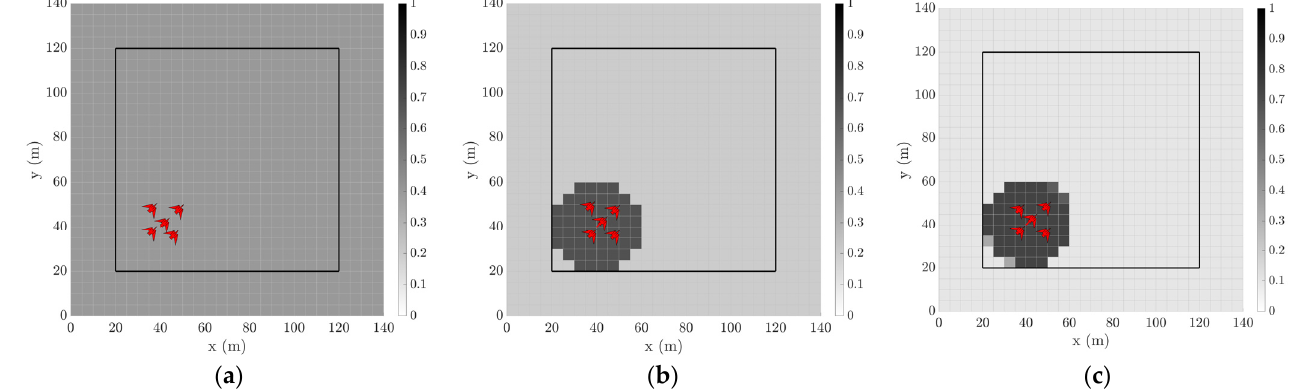
Figure 1. Target probability map over incremental time steps (darker cells represent higher probability of target occupancy based off sensor estimates while the red markers represent the true target flock position). Note flocks are not drawn to scale. ( a ) Probability grid at t = 0 s; ( b ) Probability grid at t = 1 s; ( c ) Probability grid at t = 2 s.